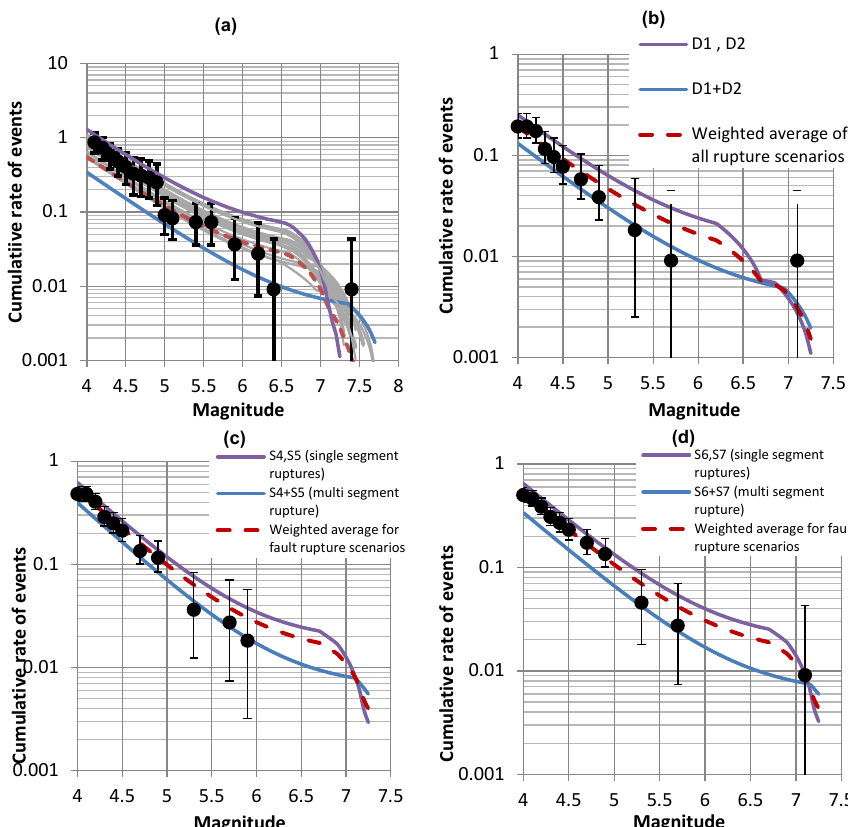
Figure 4. Cumulative rates of earthquakes for the magnitude recurrence model and associated events (moment-balancing graphs) for (a) Izmit, (b) Düzce, (c) central Marmara, and (d) Ganos/Saros rupture systems. Black points are the earthquakes associated with the rupture system; purple and blue lines show the single-segment and multi-segment ruptures; the red broken line is the weighted average of the magnitude recurrence model. In these graphs, the median values of the slip rates and M max and zone-specific b values are